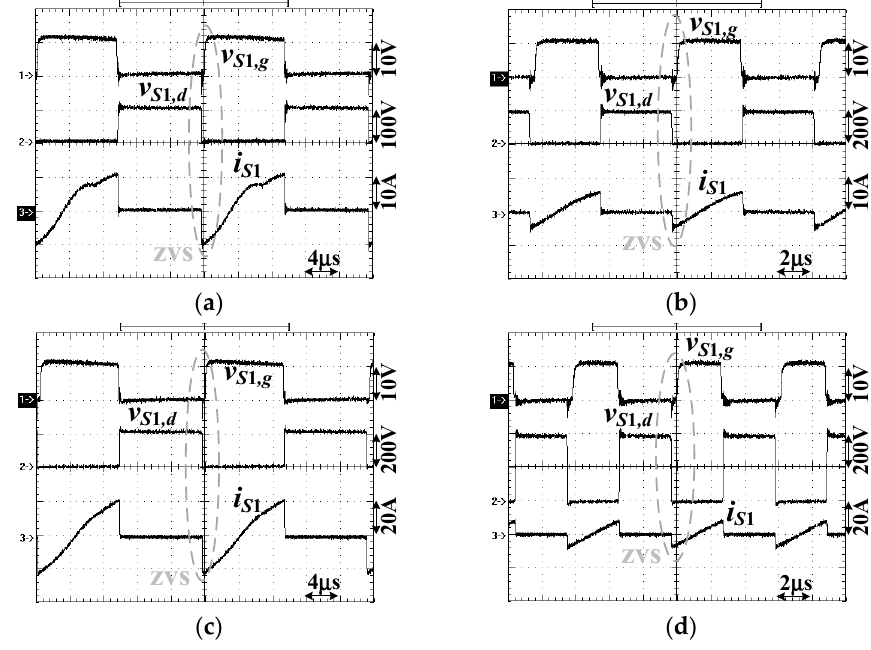
Figure 9. Measured results of v S 1 ,g , v S 1 ,d , and i S 1 at 20% power; ( a ) V in = 100 V; ( b ) V in = 190 V; ( c ) V in = 210 V; ( d ) V in = 400 V.